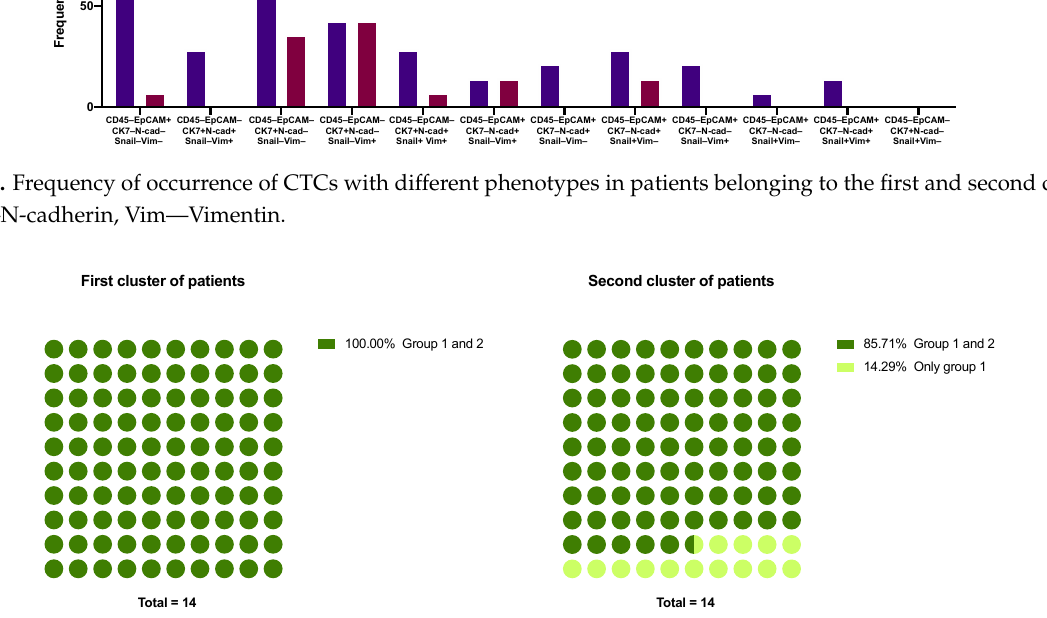
Figure 5. Variants of CTC phenotypic combinations in two clusters of breast cancer patients.